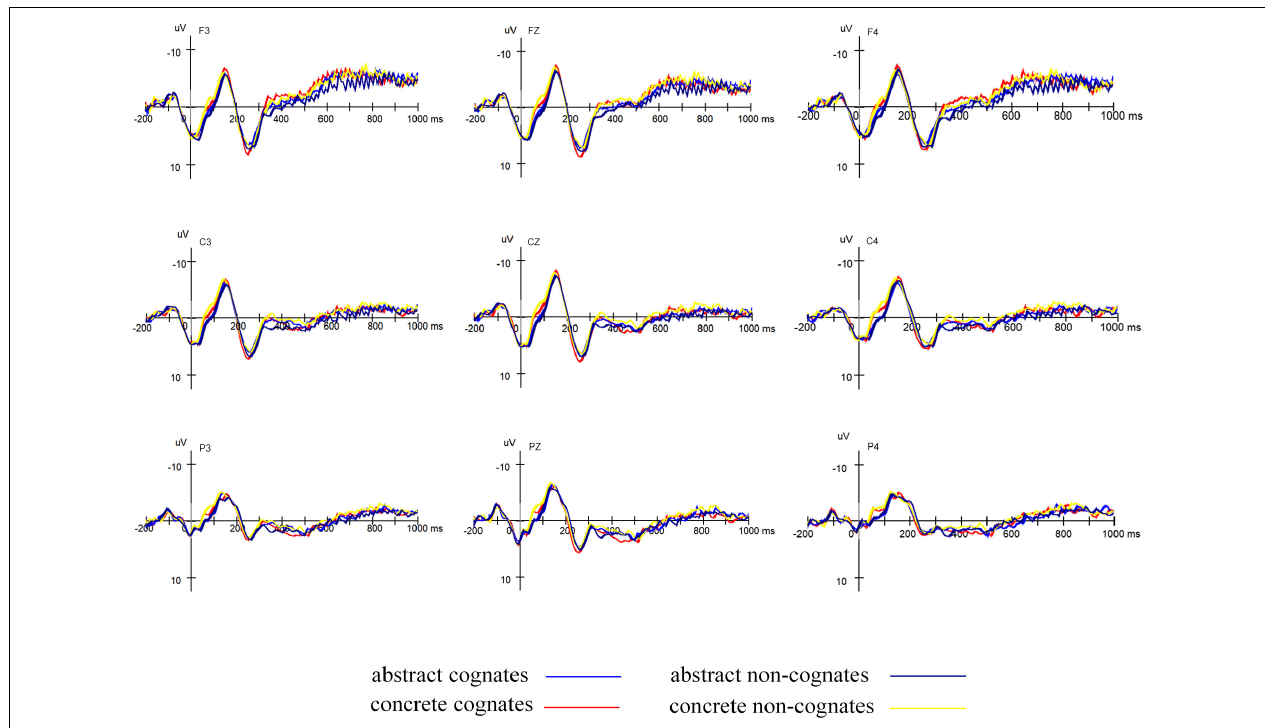
FIGURE 2 | Grand average ERPs elicited by targets primed by abstract cognates, abstract non-cognates, concrete cognates, and concrete non-cognates in L1–L2 translation direction.